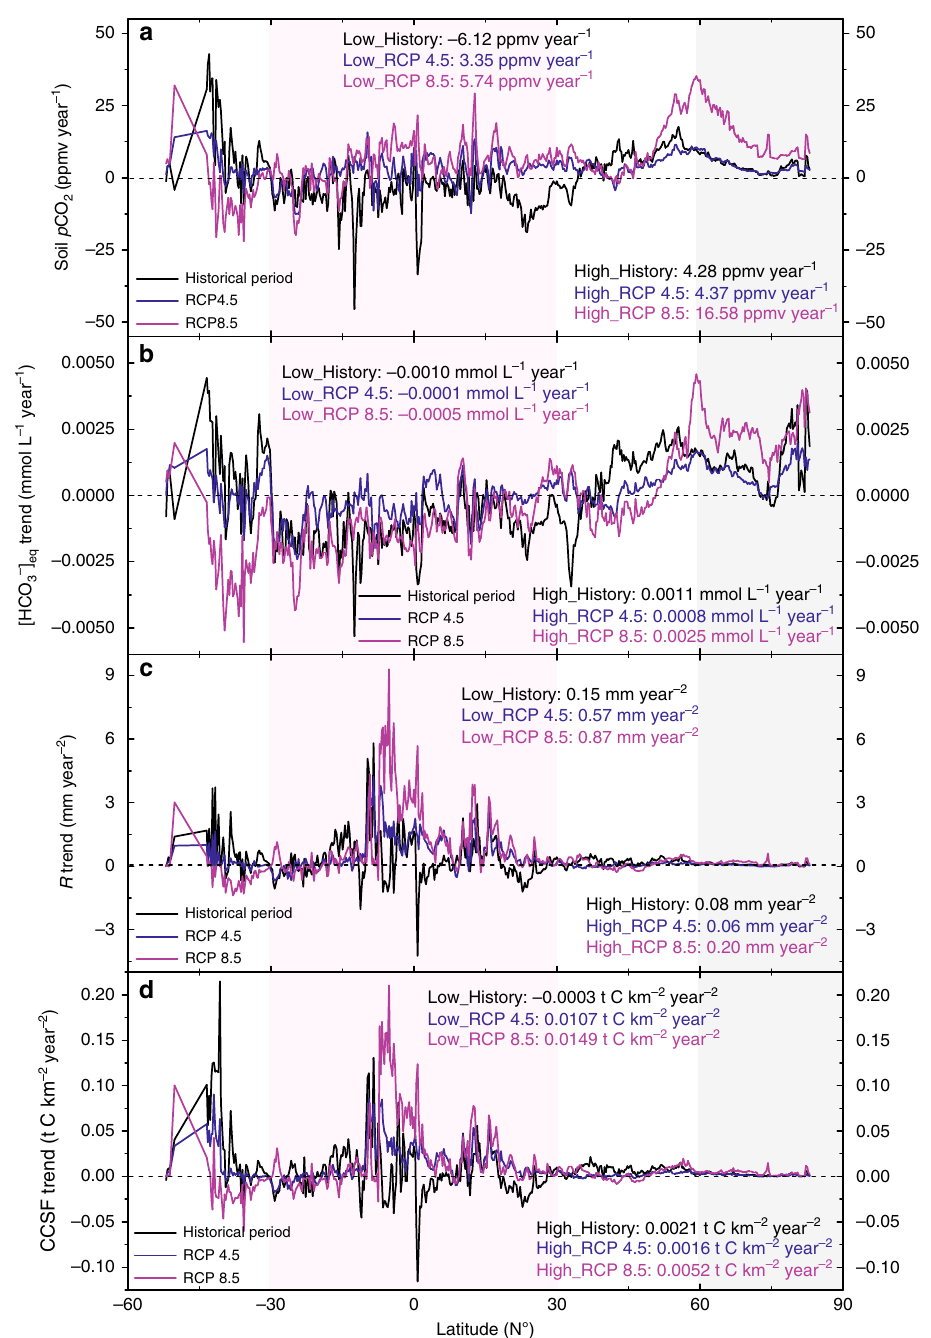
Fig. 3 Latitudinal distribution of relevant variable trends. a Soil p CO 2 , b [HCO 3 − ] eq , c R (runoff), and d CCSF trends for three cases (the historical period, and the future period for RCP4.5 and RCP8.5). The shaded areas are the northern high latitudes (60°N – 90°N, light gray) and the low latitudes (30°S – 30°N, light